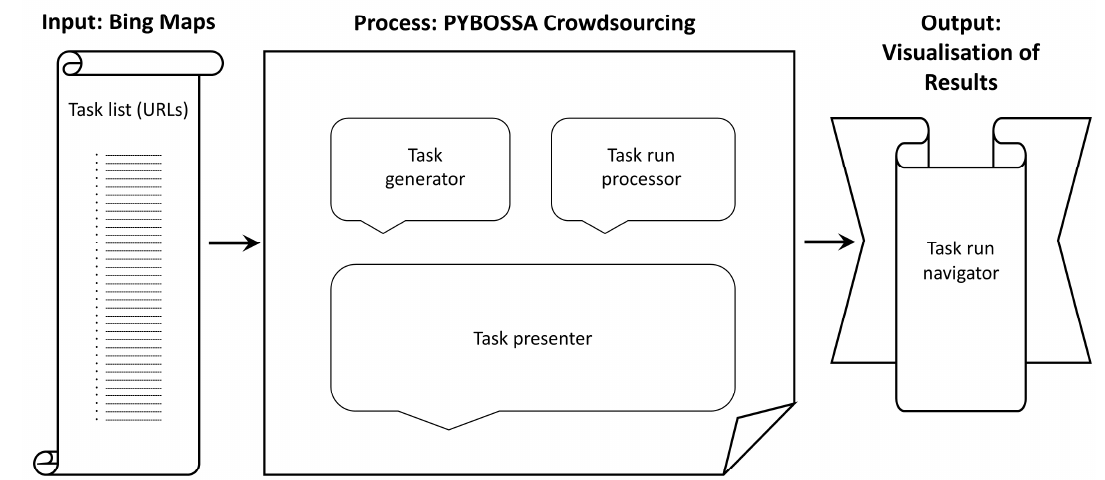
Figure 3. Diagram showing the various parts of the methodology, beginning with the list of URLs of Bing Maps Bird’s Eye tiles as input, to the PyBossa crowdsourcing implementation, and ending with the analysis of